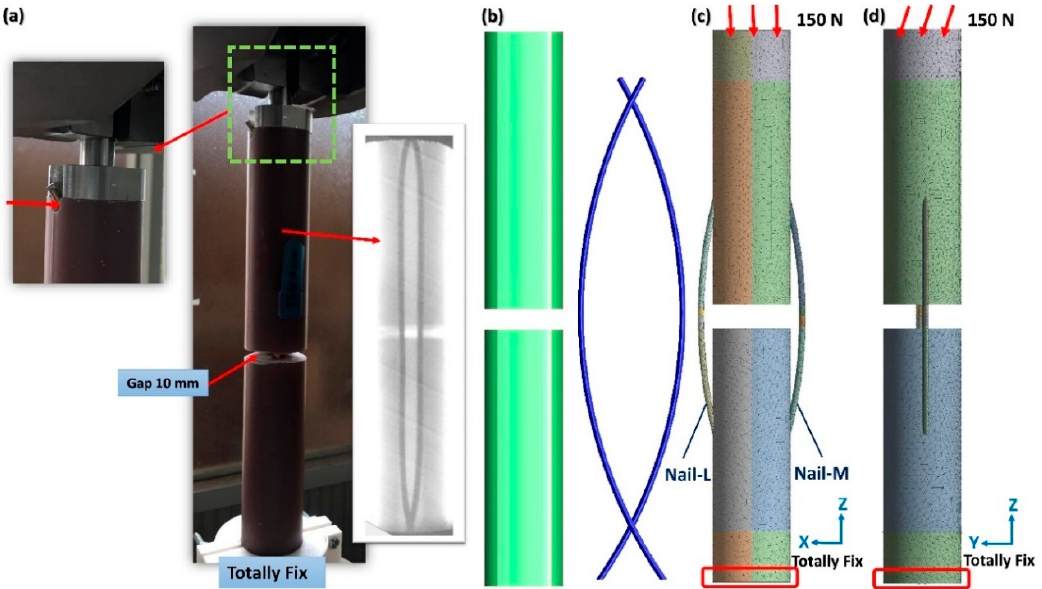
Figure 2. Sawbone model and experimental setup ( a ); The three-dimensional models of the nail and bone ( b ); Boundary conditions of axial compression ( c ) and bending ( d ).